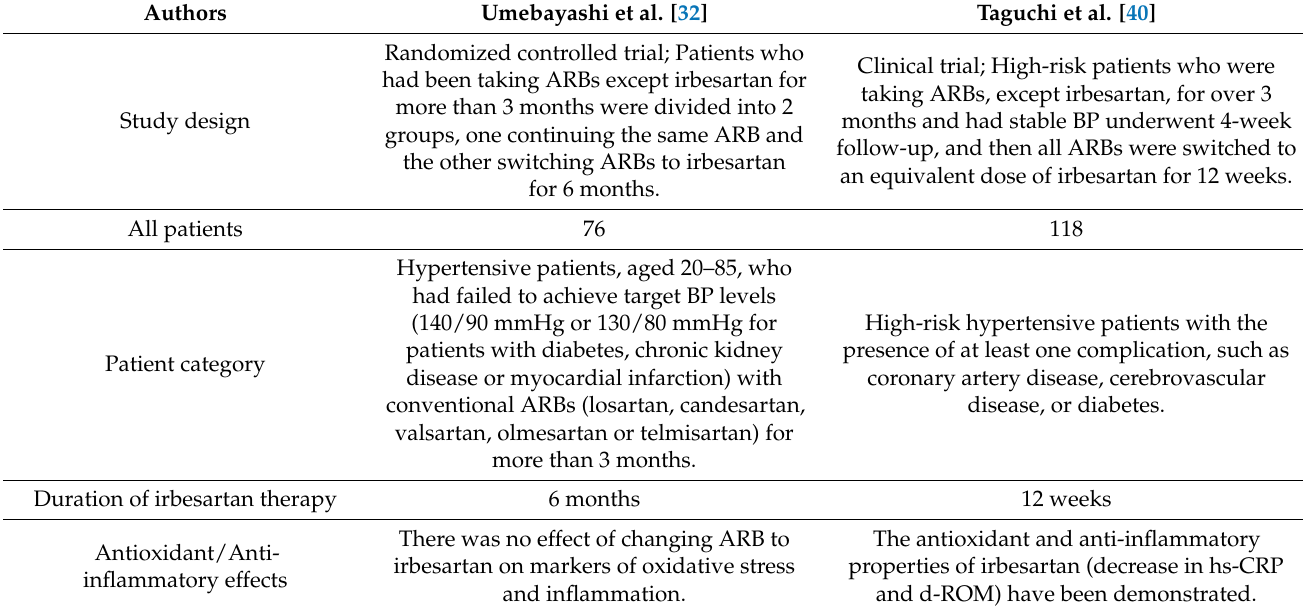
Table 7. Comparison of studies examining the antioxidant and anti-inflammatory properties of